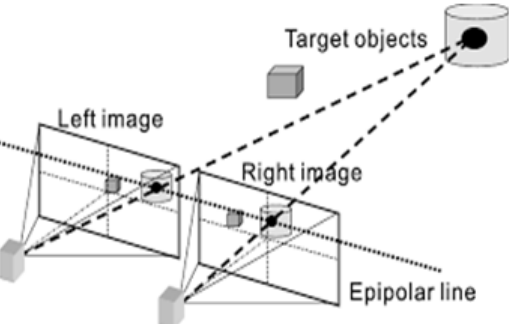
Figure 1. Stereo vision system model.